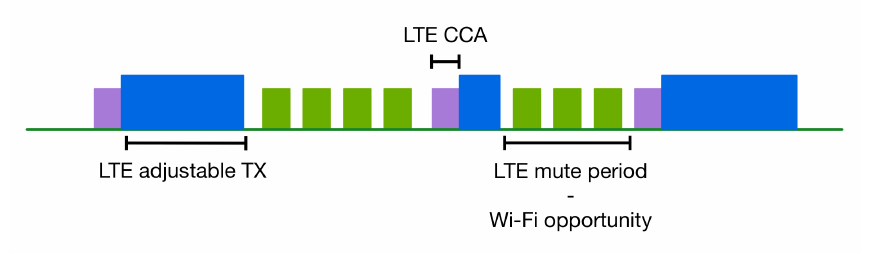
Figure 10. LTE adjustable channel occupancy time and mute